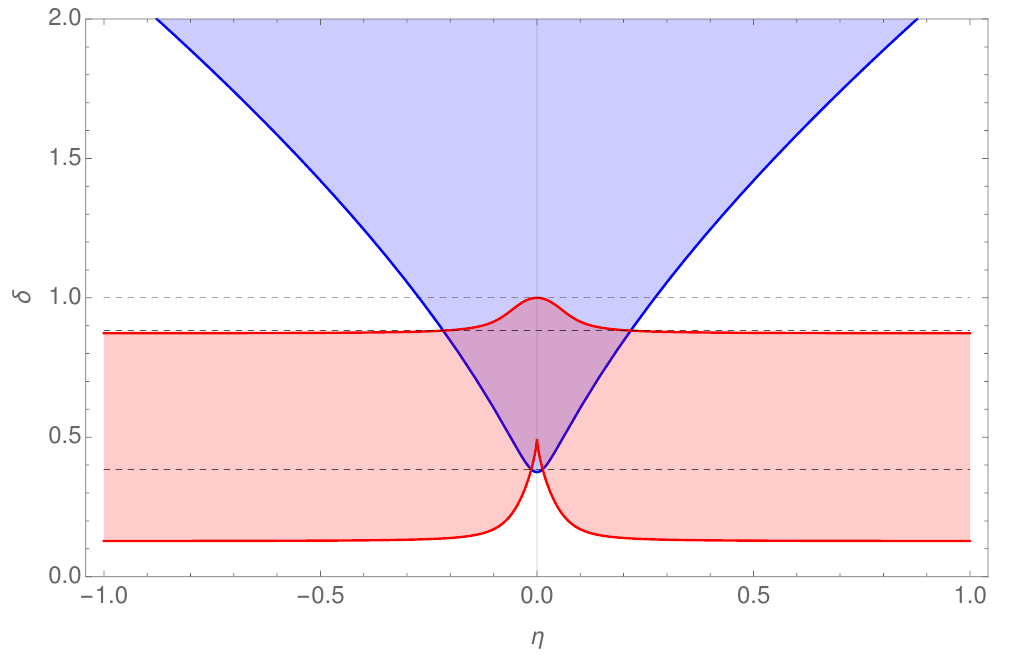
Figure 3 . The red region is where (cid:9) (1 ; 3) > 0; modular invariance implies the existence of an oper- ator in this region. The blue region is the unitarity bound set by the positivity of the Kac matrix.